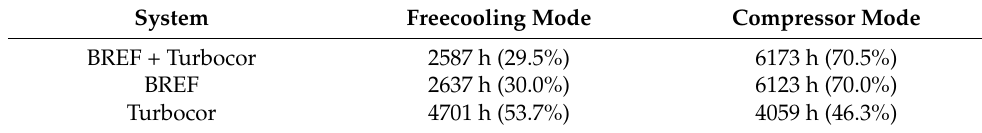
Table 2. Annual operating time of cooling systems, broken down by modes of